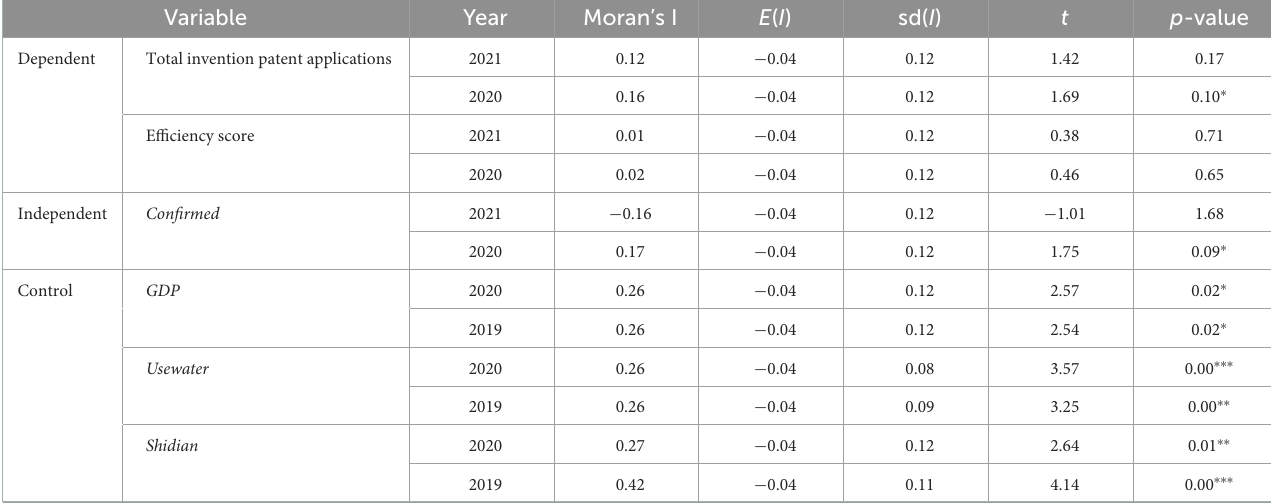
TABLE 5 Moran’s I test results for each